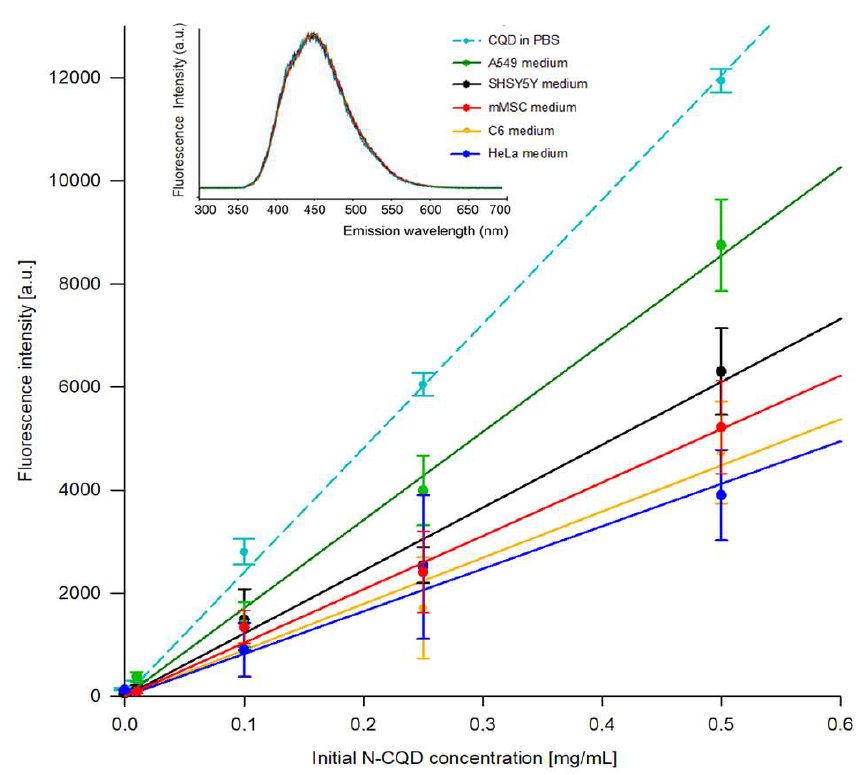
Figure 3. The decrease in N-CQD concentration in cell culture media after 72 h of culture. Inset: fluorescence emission spectra of 50 µ g/mL N-CQD in different cell culture media.